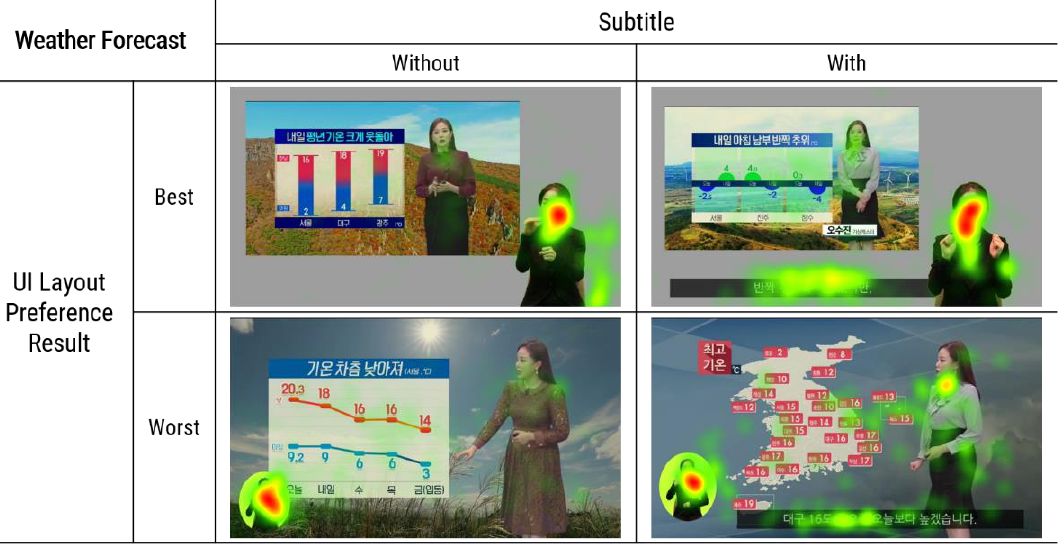
Figure 18. Results of eye tracker experiments with weather report cases.